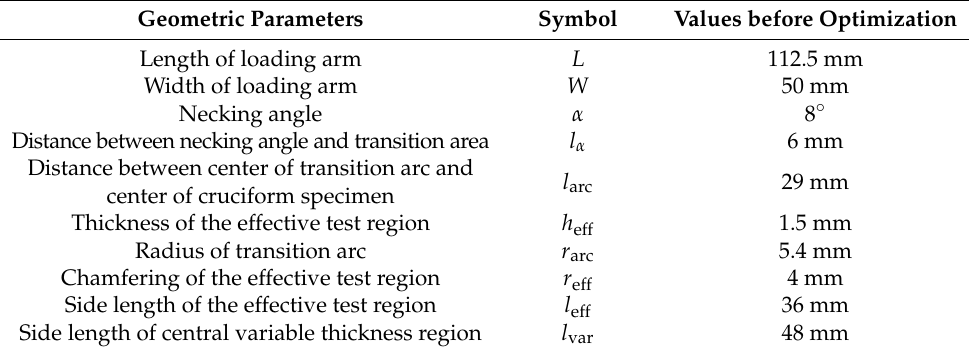
Figure 1. Initial configuration design of the CFRP biaxial specimens. ( a ) Geometric parameters, ( b ) side view of the specimen, ( c ) finite element model of the specimen. Table 1. Geometric parameters of the initial configuration of the cruciform specimen.